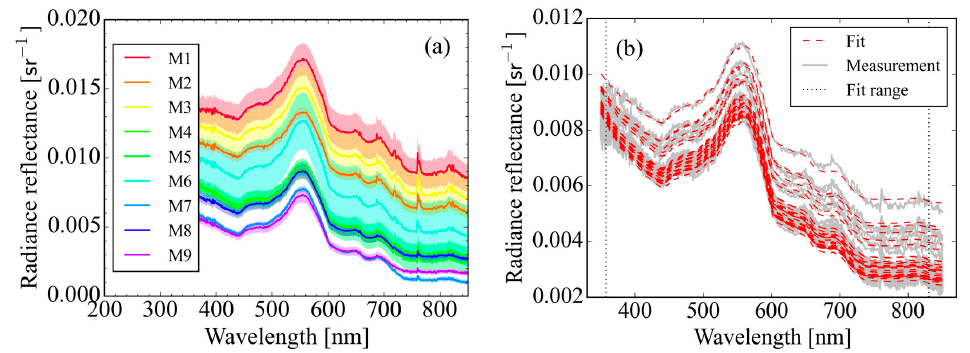
Figure 5. ( a ) Variability of radiance reflectance spectra over water; solid lines represent the mean values of the corresponding measurement series and the filled area represents the respective standard deviation per series. ( b ) Example of a reflectance series (M4) modeled with variable g dsr and d r parameters (approach G).